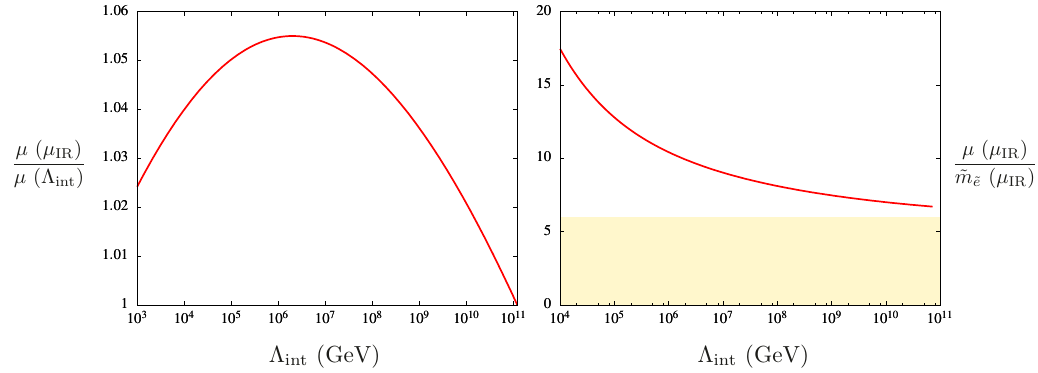
Figure 8 . In the left panel of the (cid:12)gure we show the running of the higgsino mass scaled with its initial condition for a (cid:12)xed value of tan (cid:12) = 2 : 5. On the right panel we elucidate how the low energy constraints can be translated to a bound on the intermediate scale. These constraints can come from either DM direct detection results or collider experiments. The yellow shaded region is excluded from the direct collider searches for right slepton/LSP masses close to 100 GeV for the same initial conditions as discussed